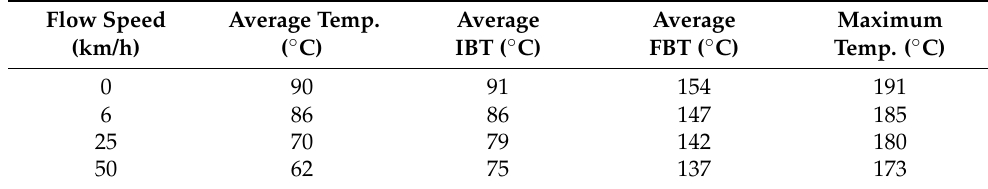
Table 2. Influence of varying flow rates on the disc temperature of a disc brake of a C-segment car (IBT = initial brake temperature; FBT = final brake temperature)